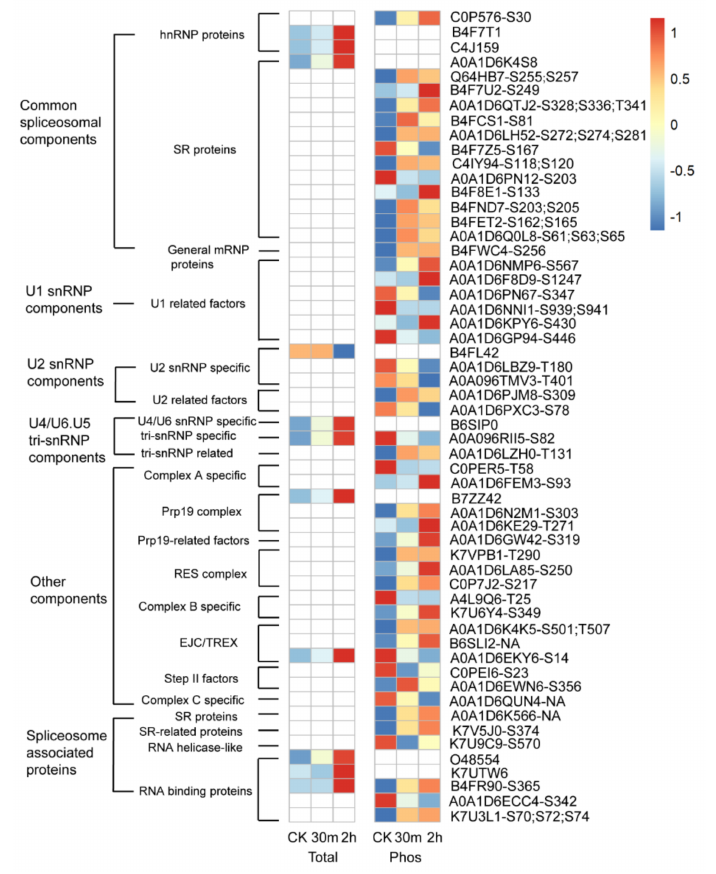
Figure 9. Expression profiles of cold-responsive spliceosome proteins at protein abundance (Total) or site-specific phosphorylation levels (Phos). Protein and phosphopeptide intensities were log2 transformed and scaled for display. Dark blue to dark red color gradient denotes lower to higher expression. One representative phosphopeptide of each phosphoprotein is shown. The accession numbers and the respective phosphosites are listed on the right of the panel. “NA” indicates the phosphosites were not confidently determined (ptmRS site probability <